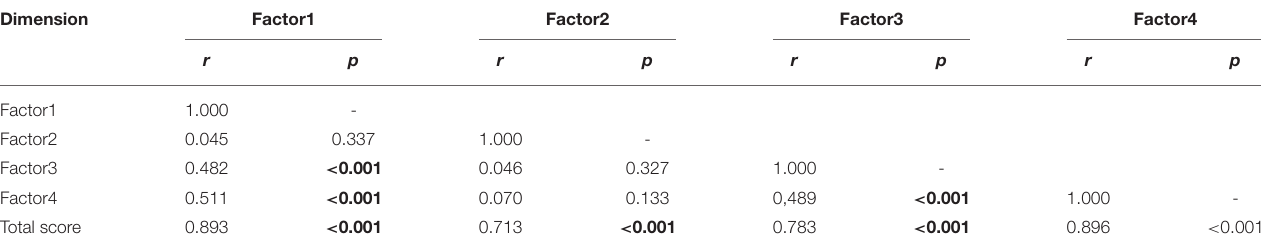
TABLE 3 | Correlations between each of the four dimension of the Happiness Index Scale (HIS) and between the dimension (factor) and the total score of the original scale.